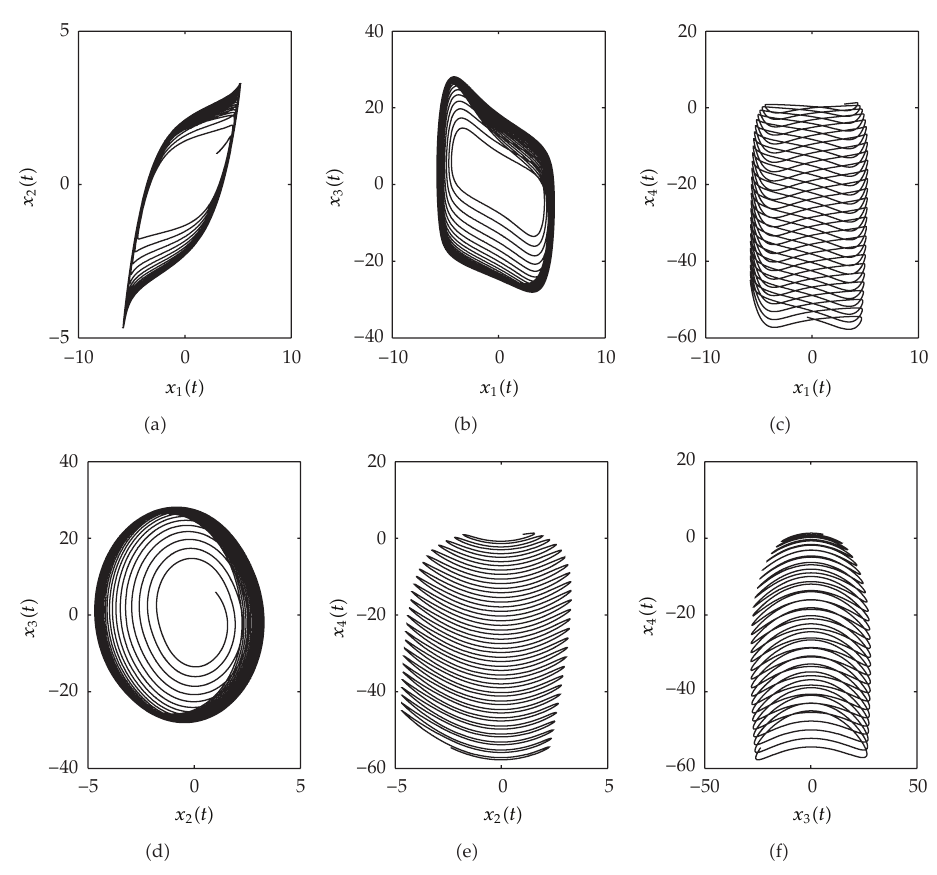
Figure 2: Phase plots for the hyperchaotic Chua